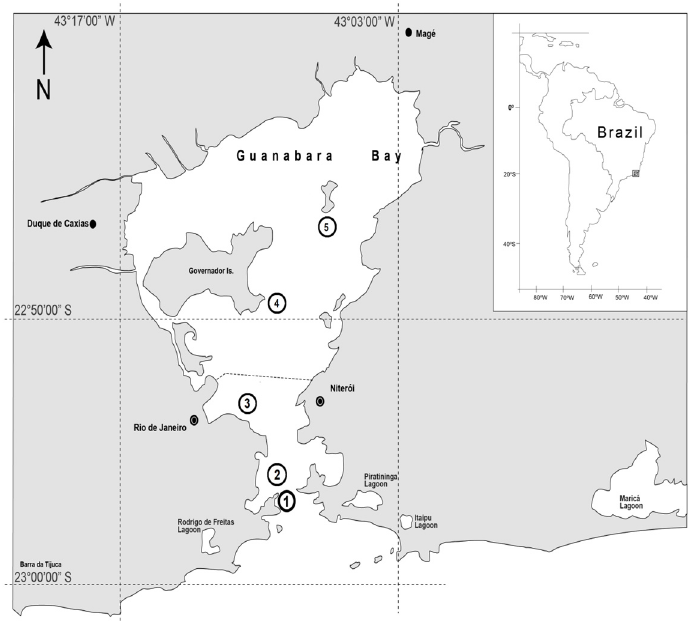
Figure 1. Guanabara Bay. Swimming crab sampling points: P1, Urca Beach; P2, Flamengo Beach; P3, Seaport of Rio de Janeiro; P4, Engenho (São Gonçalo); and P5, Paquetá Island.